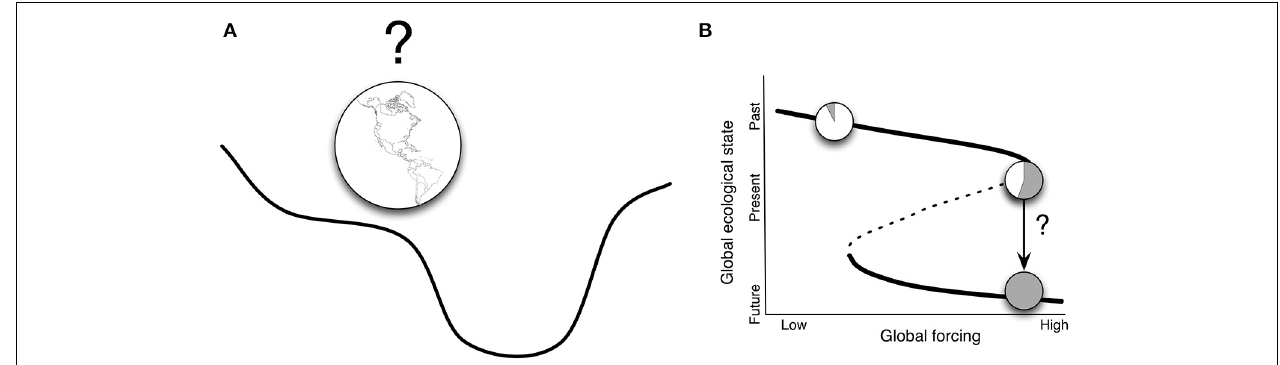
FIGURE 1 | Two representations of tipping points in Earth systems. (A) An adaptation of the cover image of Trends in Ecology and Evolution , July 2013. (B) Adapted representation of a tipping point in Earth system ecological capacity, as a fold bifurcation with